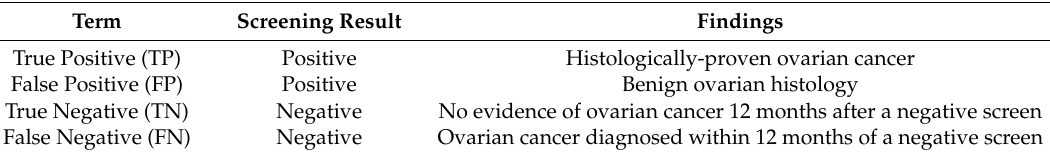
Table 1. Statistical terms and definitions used in ovarian cancer screening